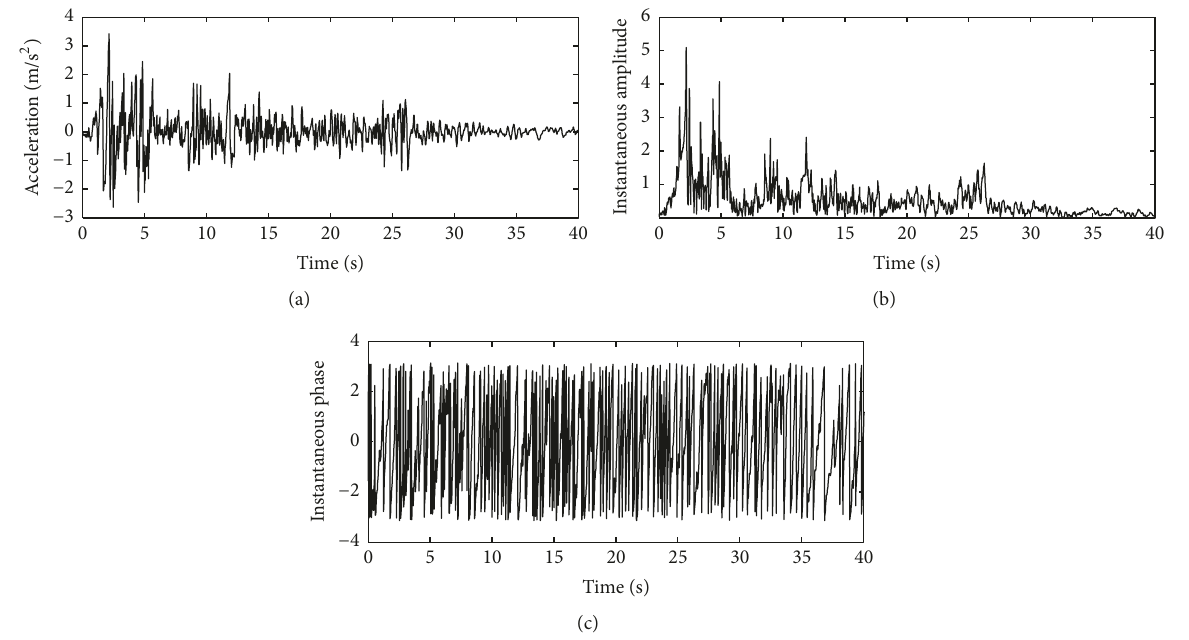
Figure 1: El Centro earthquake record: (a) acceleration; (b) instantaneous amplitude; (c) instantaneous phase angle.